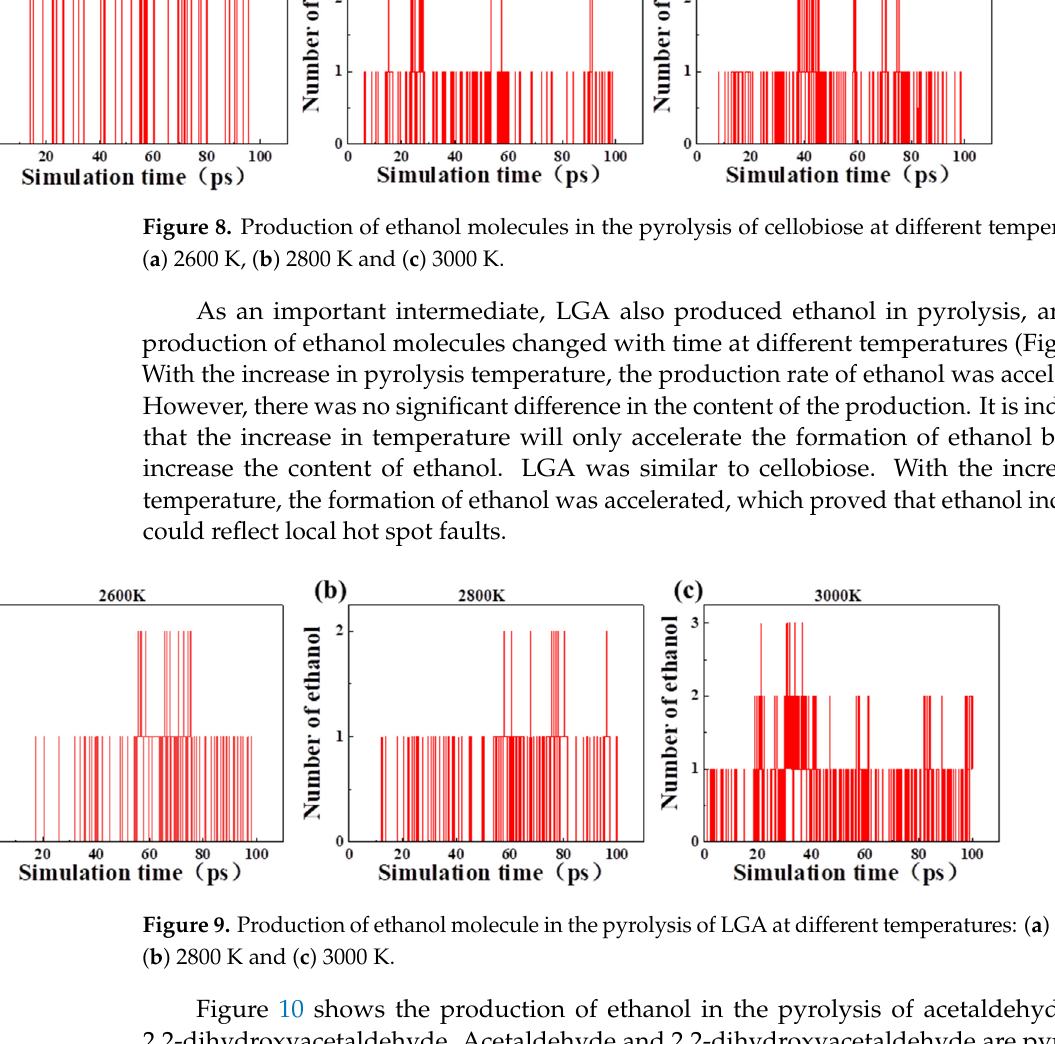
2 of 19 Figure 7. Electrostatic potential of cellobiose molecule. 3.3. ReaxFF ‐ MD of Cellobioses 3.3.1. Production of Ethanol in the Pyrolysis In the pyrolysis of cellobiose, the production of ethanol molecules changed with time at different temperatures (Figure 8). No ethanol was found when the temperature was lower than 2400 K, and some ethanol molecules appeared at 2600 K, 2800 K, and 3000 K.